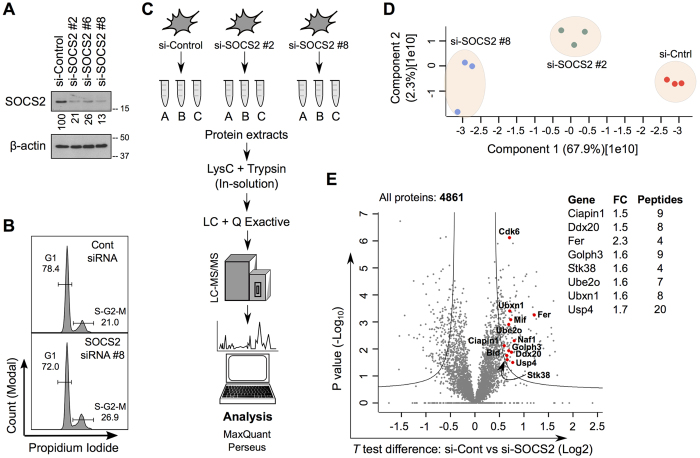
Global identification of proteins upregulated by SOCS2 depletion.(A) MEFs were transfected with either a non-targeting (NT) siRNA or three different siRNAs against SOCS2. Cell lysates were prepared 36 hrs after transfection and immunoblotted (IB) with the indicated antibodies. Numbers indicate % remaining protein, SOCS2/β-actin. (B) FACS analysis of MEFs transfected with si-SOCS2 #8. (C) Schematics of the proteomic workflow. (D) Principal component analysis of si-Control, si-SOCS2 #2 and si-SOCS2 #8 samples using LFQ intensities by the Perseus platform (n = 3). (E) Volcano plot of distribution of proteins identified in this study. Upregulated proteins (P-value < 0.05 and Fold change >1.5) reported in the literature to have a direct functional link with NF-κB are annotated. Right panel enlists genes corresponding to the annotated proteins which regulates NF-κB activity. “Fold change” and “unique peptides” are indicated.